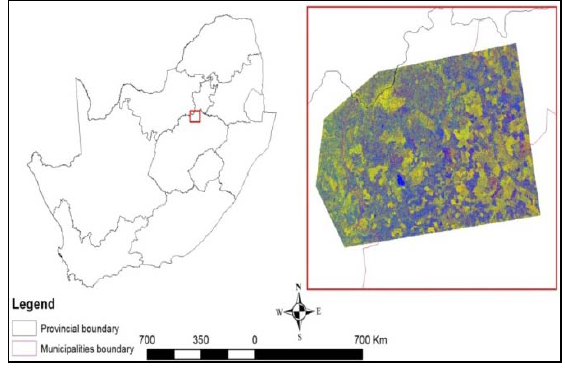
Figure 1: Study area within the Free State province of South Africa (image is a multiple composite SAR of VV, VH and abs(VV*VH)